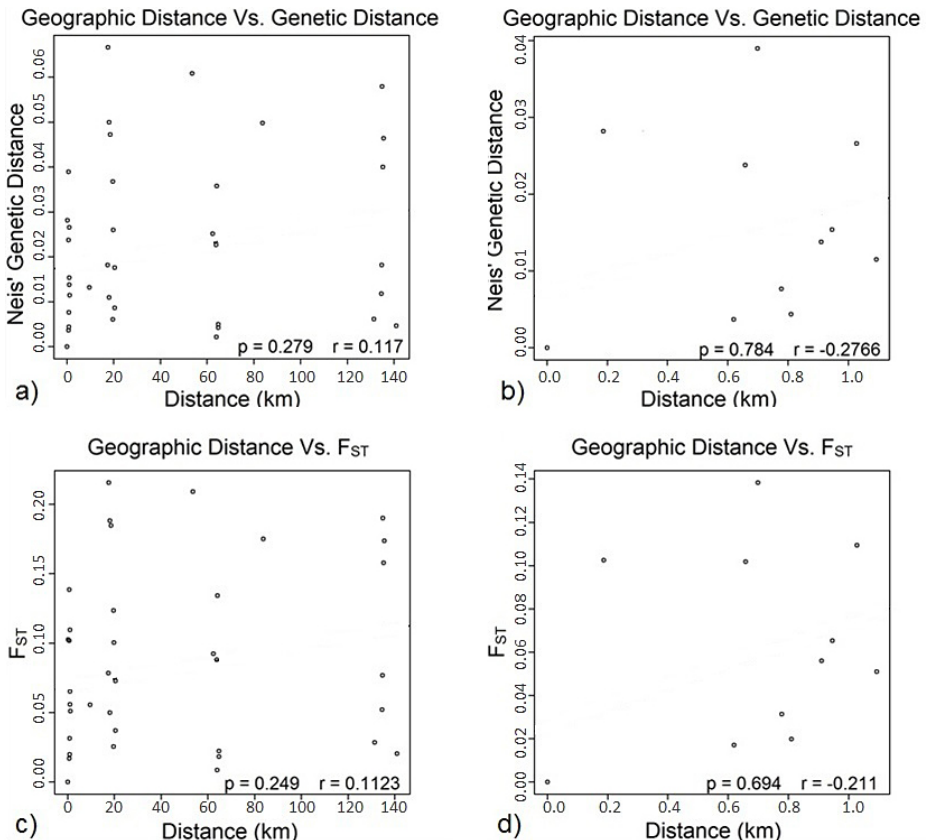
Figure 3. Isolation by distance: plots of pairwise estimates of Nei’s genetic distance (top row: a and b ) and F ST (bottom row: c and d ) versus geographic distance in km between individual plant samples of Honckenya peploides from; ( a and c ) Mainland Iceland, Surtsey and Heimaey, and ( b and d ) Surtsey only. Statistical significance was assessed using a Mantel